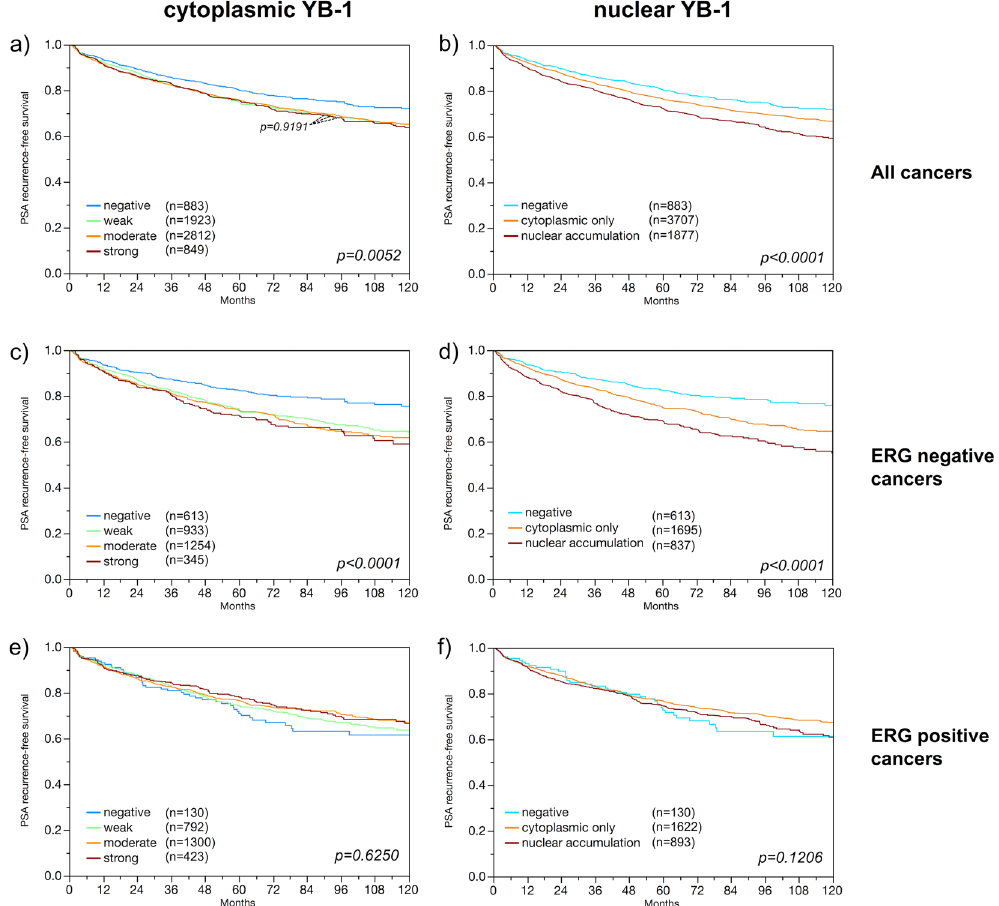
Figure 4. Prognostic impact on prostate specific antigen (PSA) recurrence after radical prostatectomy of cytoplasmic YB-1 expression and nuclear YB-1 accumulation in all cancers ( a , b ), ERG fusion positive cancers ( c , d ) and ERG fusion negative cancers ( e , f